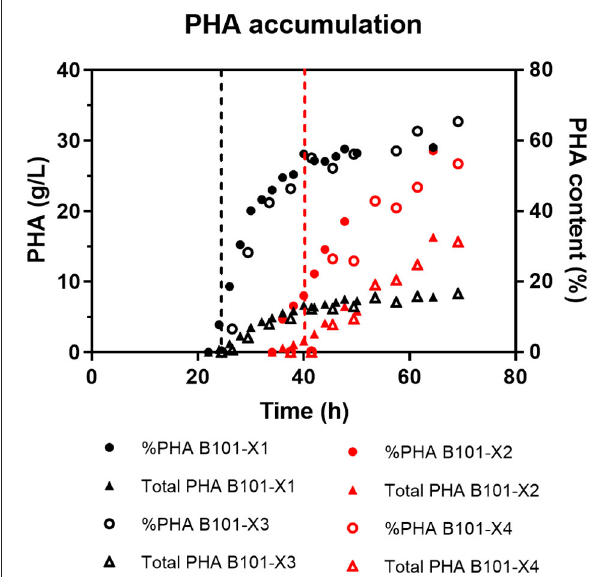
FIGURE 2 | PHA (g/L, left y-axis) and content (%, right y-axis) obtained for each fed-batch cultivation. B101-X1 and B101-X3 refer to experiments under nitrogen limitation (black dots/lines), while B101-X2 and B101-X4 refer to experiments under phosphorus limitation (red dots/lines). Black dashed lines mark the start of the accumulation phase under nitrogen limitation, while red dashed lines mark the start of the accumulation phase under phosphorus